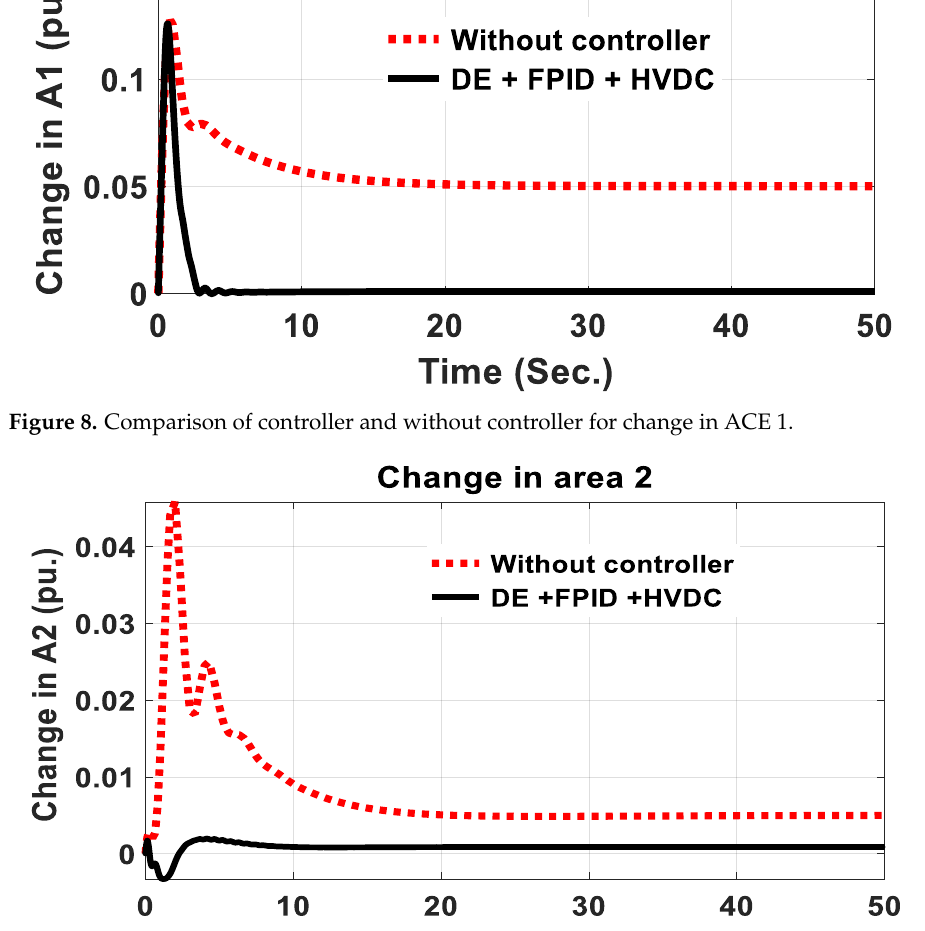
Figure 9. Comparison of controller and without controller forchange in ACE 2.